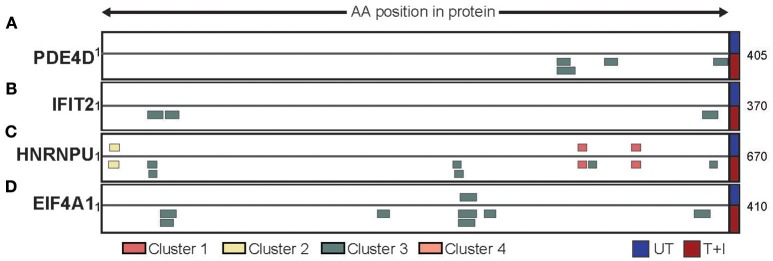
Different protein repertoires presented following stimulation. The presented peptides from (A) PDE4D, (B) IFIT2, (C) HNRNPU, and (D) EIF4A1 are shown aligned to their position on the protein sequence. Only the portion of the protein which had peptides identified is shown (start and end position are marked) and peptides are colored by the cluster which they were assigned to. The peptides identified in unstimulated cells (UT) are presented above the protein while the peptides identified in stimulated cells (T+I) are below.